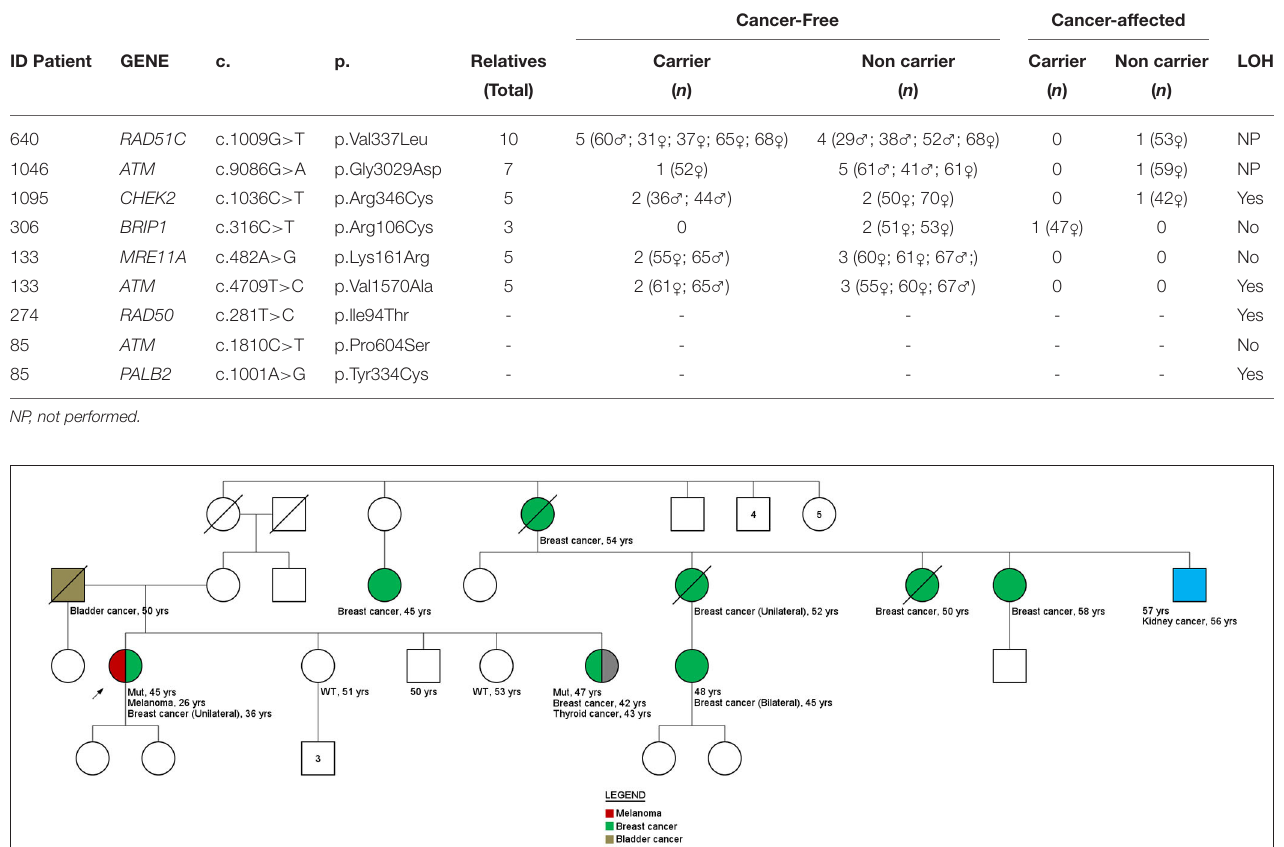
TABLE 3 | Segregation and LOH analysis.